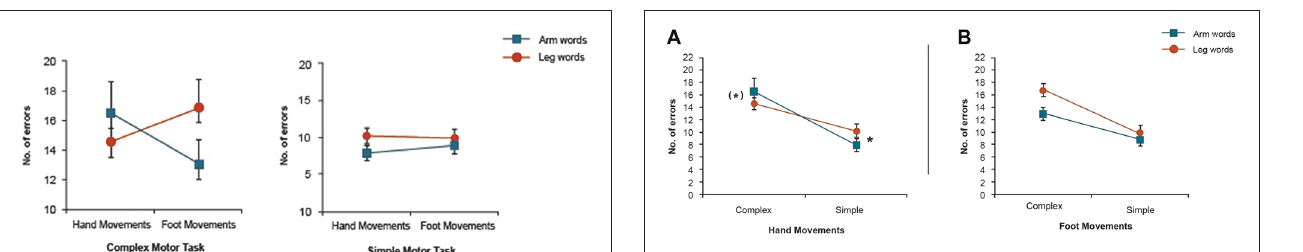
FIGURE 3 | 2 × 2 Analysis of variance (ANOVAs) of the movement conditions in both experiments. (A) Cross-over Word Category × Task Complexity interaction in the hand movement conditions showing a significant Word Category difference in the complex motor task. This result demonstrates that changes to the complexity of the motor task reversed the pattern of interaction from interference to facilitation in the hand movement condition. (B) Word Category × Task Complexity interaction in the foot movement conditions. ∗ Indicates significance. ( ∗ ) Indicates near significance.